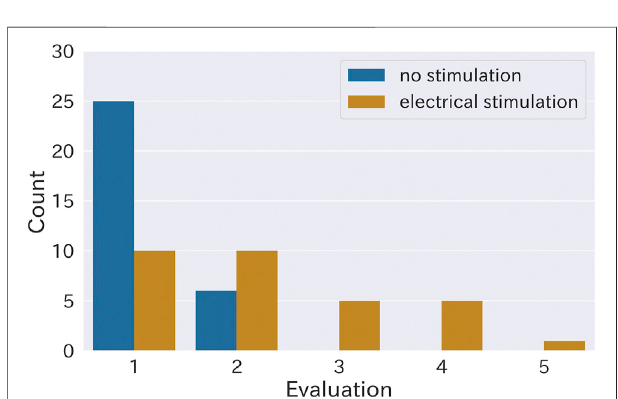
FIGURE 11 | Evaluation results of discomfort for each condition in the experiment 1. The numerical values indicate 1: none, 2: low (not bothersome), 3: mild (bothersome in daily life, but not unbearable), 4: moderate (bearable in testing, but unbearable in daily life), and 5: severe (unbearable).